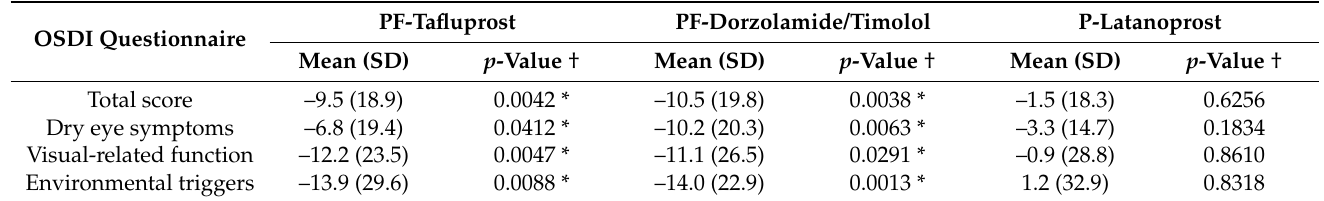
Table 2. Change in OSDI from baseline to 12-week follow-up in all patients in the FAS1 population ( n =